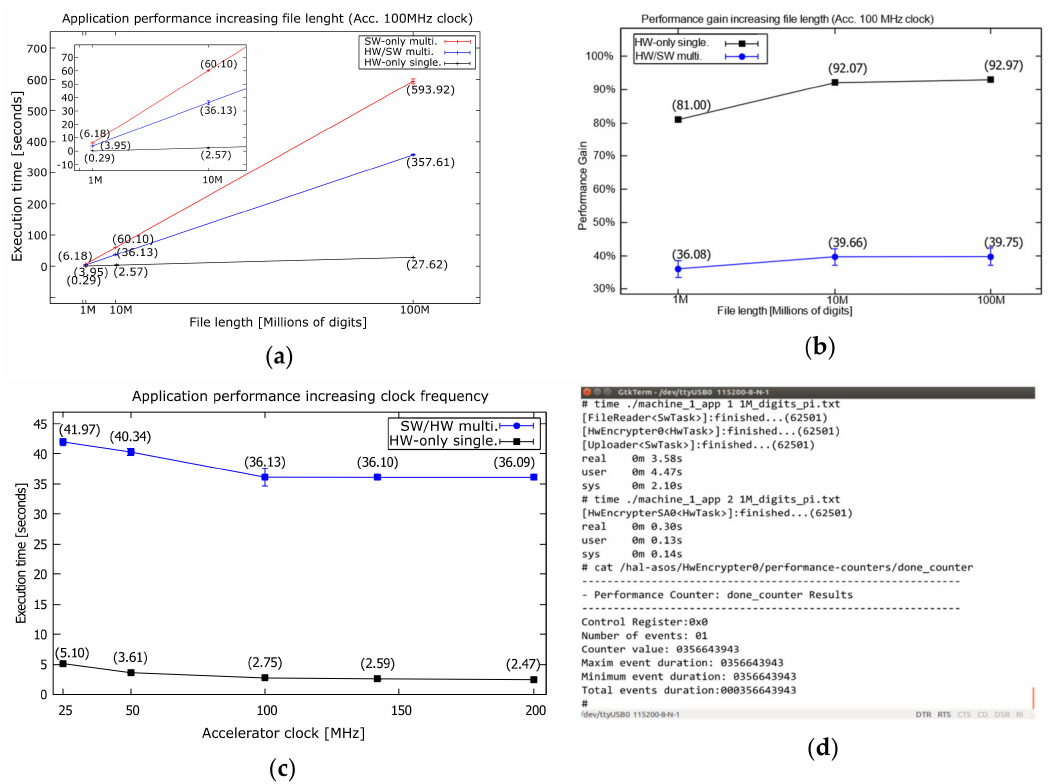
Figure 8. Performance results of: ( a ) the software-only multi-task version and the two software and hardware multi-task and single-task applications when using a 100 MHz clock frequency in the accelerators; ( b ) the two software and hardware applications over the software-only version using the same clock frequency; ( c ) the two software and hardware applications using 10 million digits while increasing the clock frequency. ( d ) The console output while executing the software and hardware applications using one-million digits of π